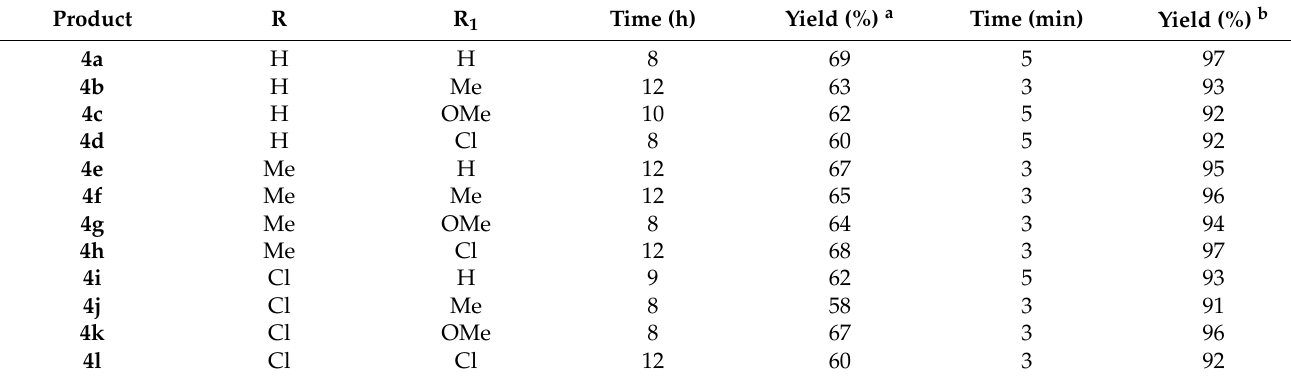
Table 1. Comparison between the conventional heating procedure (method A) and microwave irradiation (method B) for the synthesis of compounds 4a–l